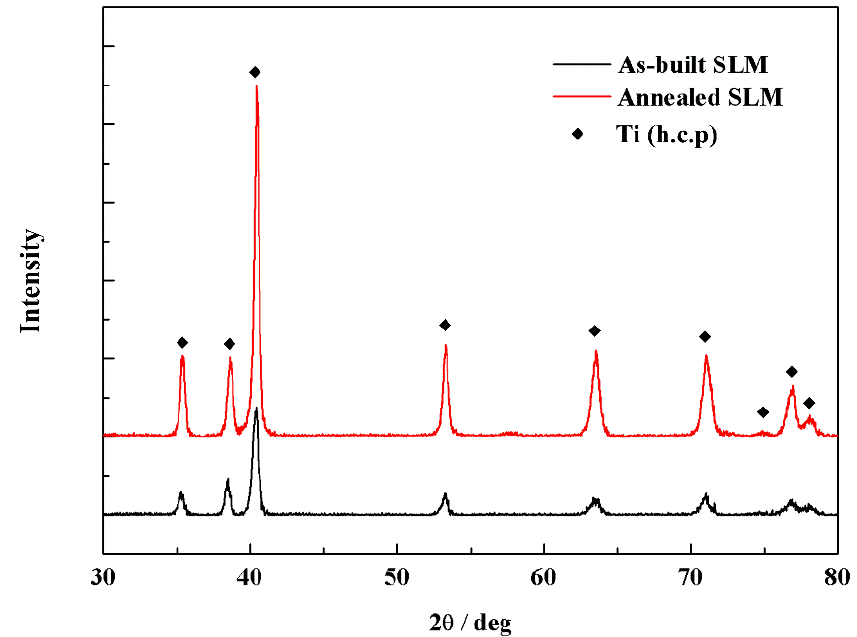
Figure 5. X-ray diffraction (XRD) patterns of as-built and annealed selective laser melting (SLM) Ti – 6Al – 4V samples.